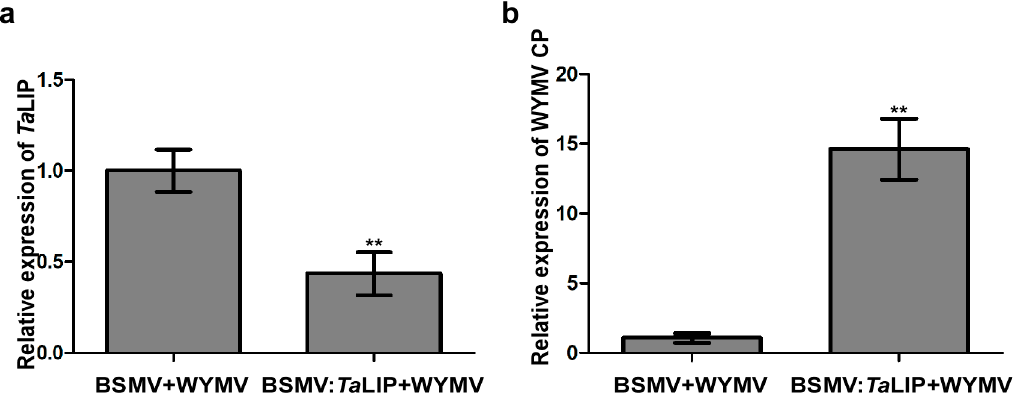
Figure 6. Silencing TaLIP gene expression through virus-induced gene silencing (VIGS) significantly promoted WYMV infection in Triticum aestivum . ( a ) The quantitative RT-PCR analysis of WYMV CP expression in the inoculated leaves harvested from the TaLIP -silenced or non-silenced plants. ( b ) Quantitative RT-PCR analysis of TaLIP expression silenced by BSMV-mediated VIGS in Triticum aestivum . The TaCDC was used as the internal control. Bar represents the SD of three experiments (each with three technical replicates), Asterisks indicate ** p < 0.01 to the amount of relative WYMV CP and TaLIP expression by the Student’s t